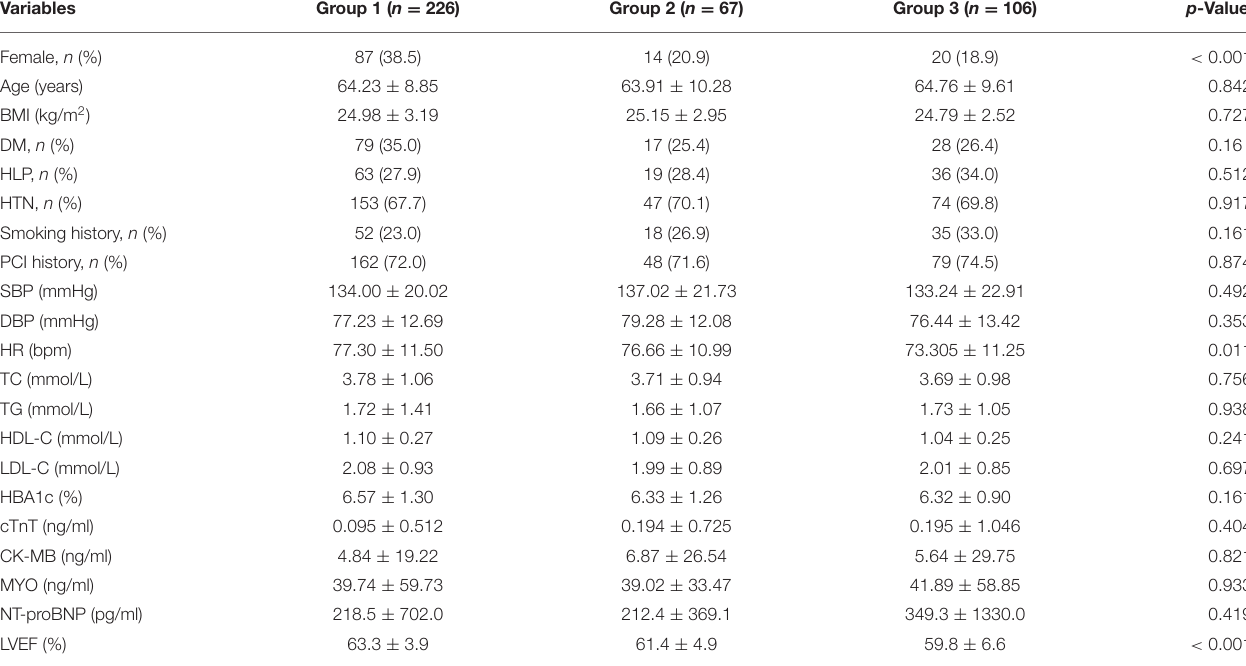
TABLE 1 | Baseline characteristics of the study population.